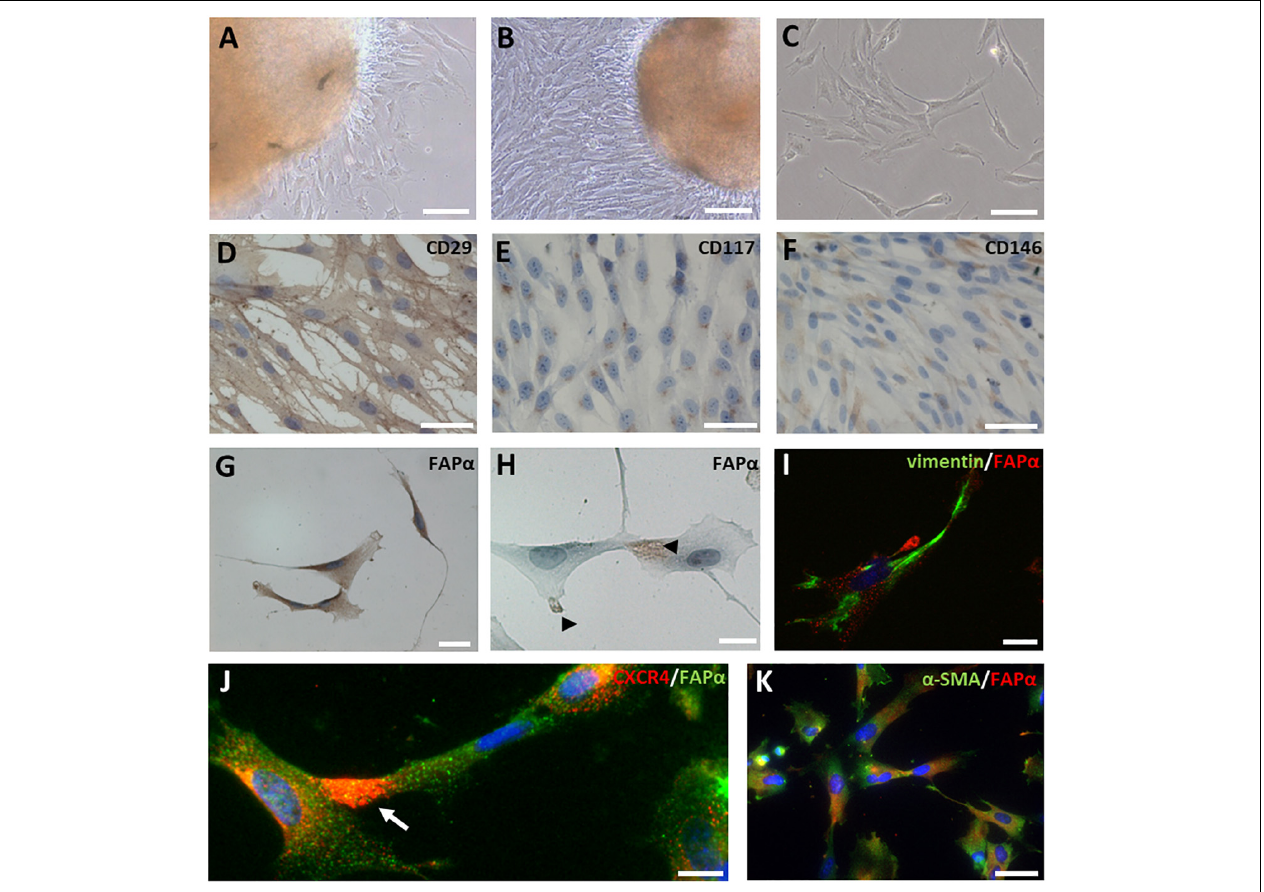
FIGURE 3 | FAP α expression in SCAPs in culture. (A–C) SCAPs, isolated via the explant method, migrated out of the tissue explants, and displayed a spindle-shaped morphology. Cells were able to form colonies in vitro (C) . (D–H) Immunocytochemical staining of SCAPs for mesenchymal markers CD29, CD117, CD146, and FAP α . All cells expressed CD29 (D) and CD117 (E) . A subpopulation of the cells stained positive for CD146 (F) . FAP α staining was prominent in all cells and was visible on either the plasma membrane (G) or on pseudopodia (H) . (I) Double immunofluorescent staining (I–K) shows that FAP α positive SCAPs (red) co-express vimentin ( I , green). (J) CXCR4 staining (red) was observed in pseudopodia (arrow) of FAP α expressing cells (green). (K) Diffuse α -SMA was observed in FAP α + SCAPs (green). Nuclei are counterstained with DAPI (blue). Scale bars represent 20 (H,I,K) , 40 (G) , 50 (D–F,J) , 100 (A–C) µ